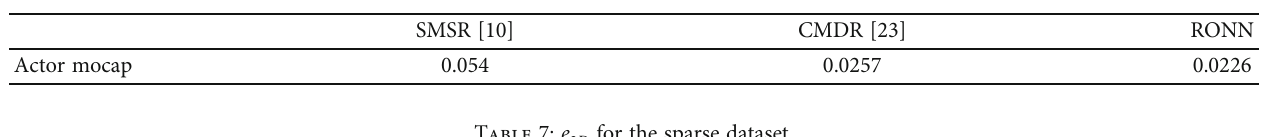
Table 6: e for the actor mocap dataset [19]. 3 D